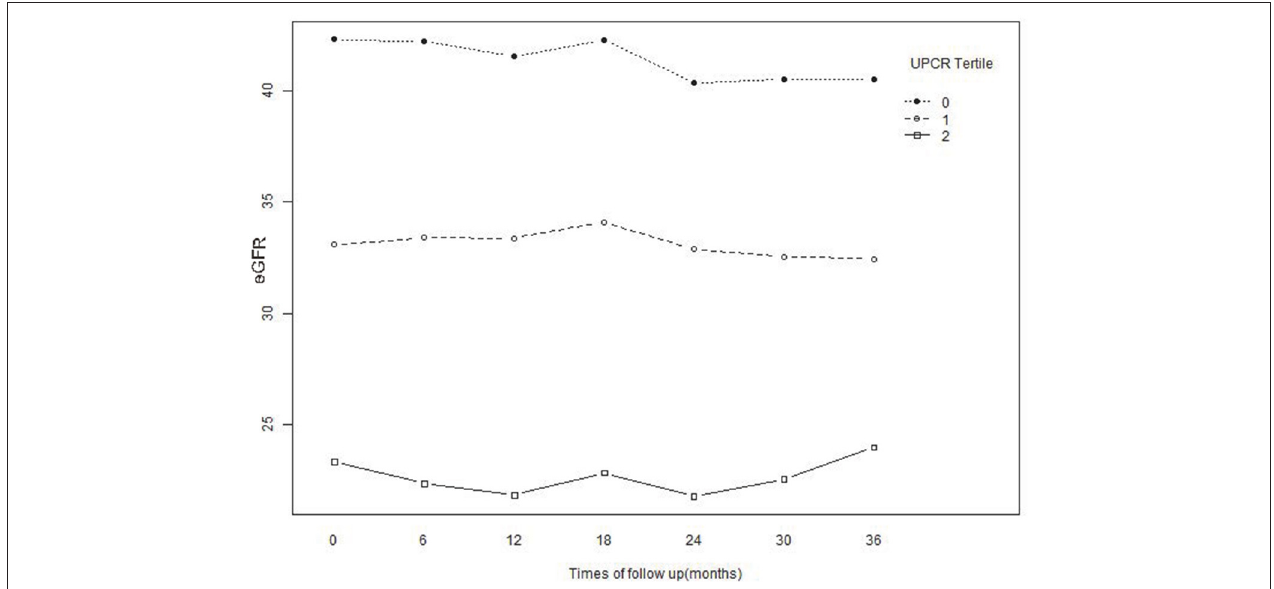
FIGURE 6 | Baseline and predicted 3-year longitudinal changes in eGFR for the patients with UPCR at baseline were divided into three groups according to tertile. The patients whose baseline UPCR was in the lowest tertile showed an accelerated decrease in eGFR compared with the other two